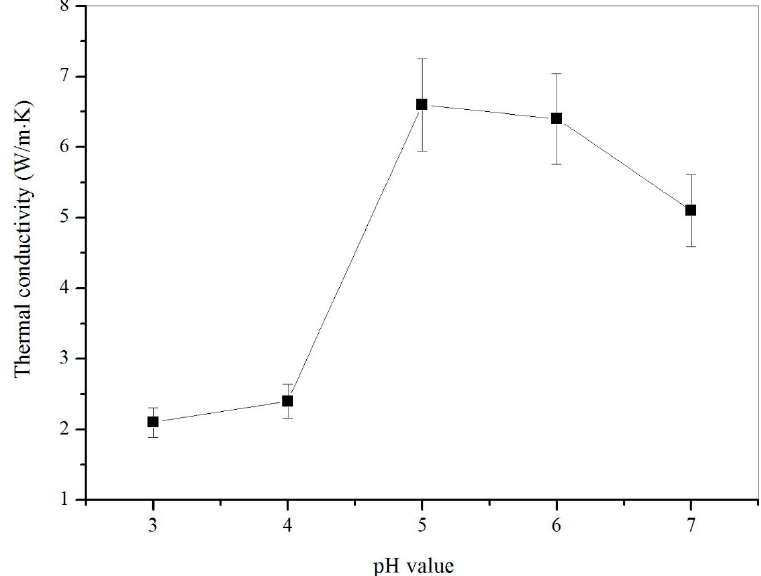
Figure 13. Thermal conductivity of microcapsule samples (M-3, M-4, M-5, M-6 and M-7) fabricated under various pH values.